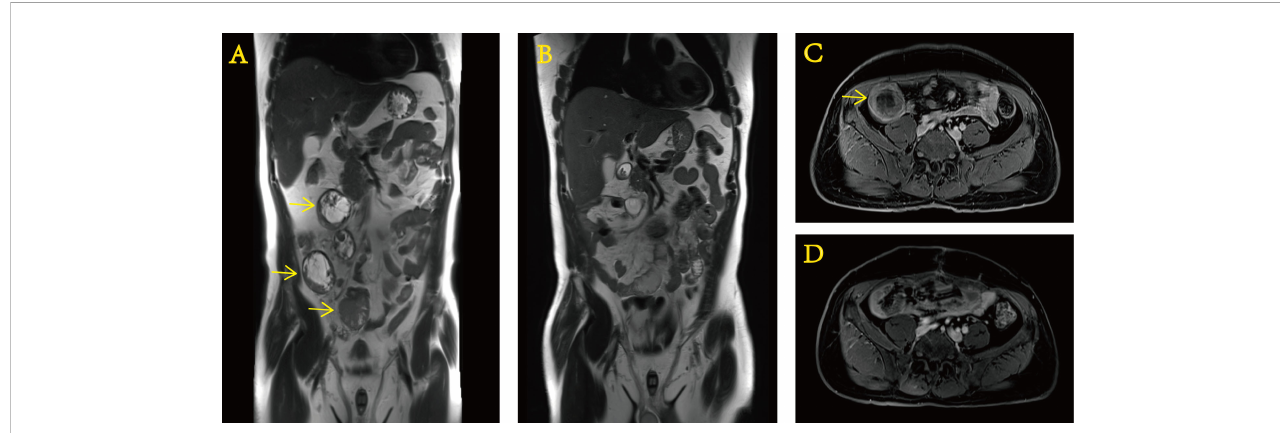
FIGURE 4 Preoperative and postoperative contrast-enhanced MRI of the abdomen. Preoperative (A) coronal and (C) transverse sections. Postoperative (B) coronal and (D) transverse